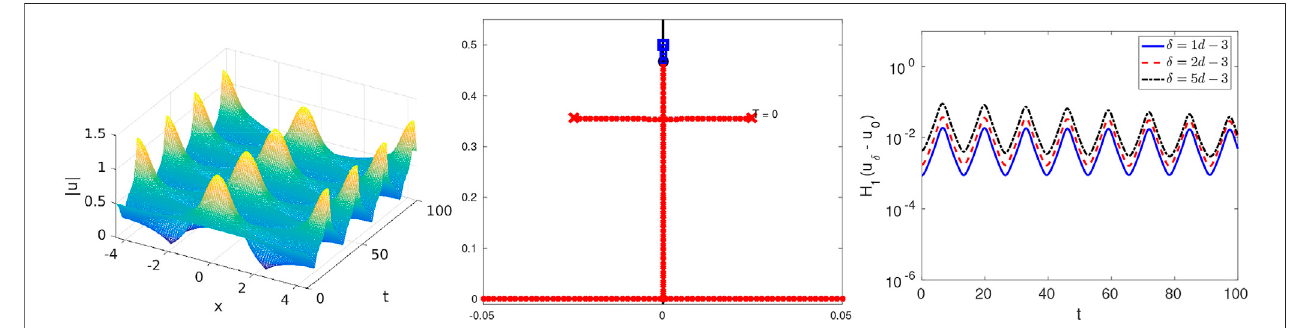
FIGURE 2 | NLS cross state: (A) | u 0 ( x , t )| for 0 ≤ t ≤ 100, (B) it ’ s spectrum at t (cid:1) 0, (C) η ( t ) for u δ ( x , 0 ) (cid:1) u 0 ( x , 0 ) + δ g 1 ( x )